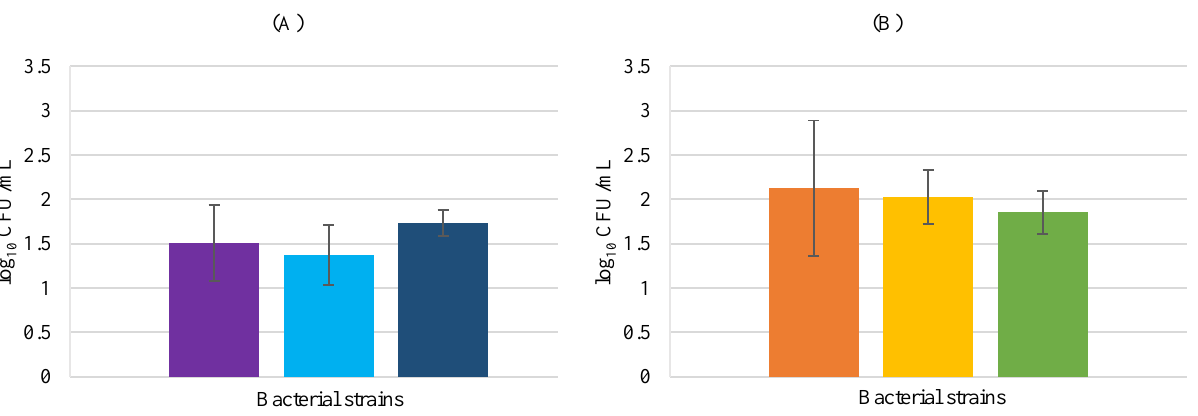
Figure 4. HaCaT cell invasion by S. aureus in the presence of probiotic bacteria. S. aureus counts in BHI medium ( A ) Lacticaseibacillus rhamnosus ( ■ ), Lactobacillus delbrueckii subsp. bulgaricus ( ■ ), and Propioniferax innocua ( ■ ); counts in MRS medium ( B ) Lacticaseibacillus rhamnosus ( ■ ), Lactobacillus delbrueckii subsp. bulgaricus ( ■ ), and Propioniferax innocua ( ■ ). Error bars are ± standard deviation.